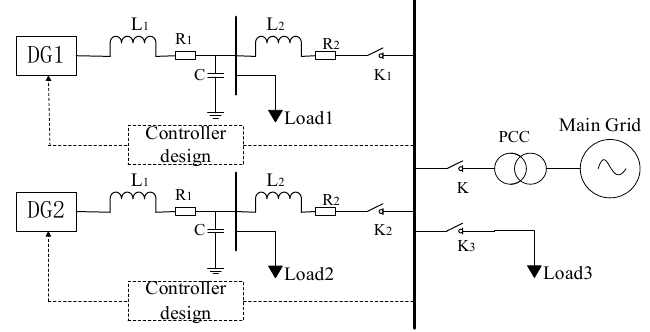
Figure 1. Microgrid peer-to-peer control.